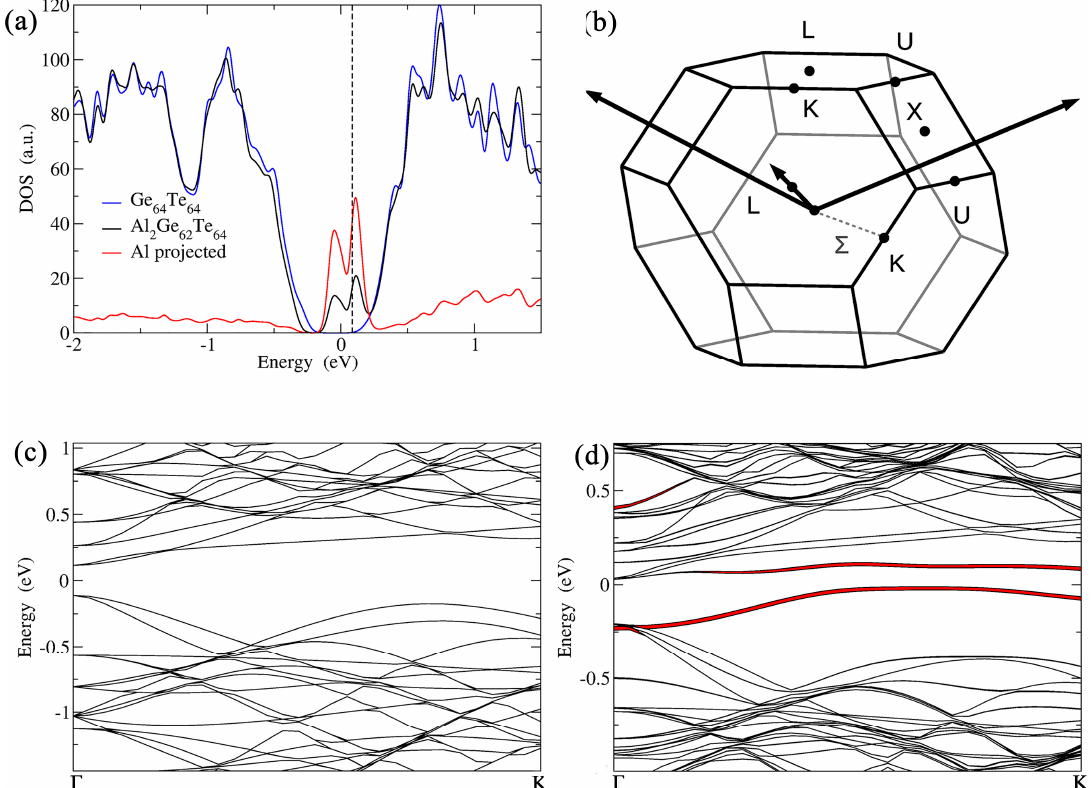
Figure 4. ( a ) Calculated DOS for Al 2 Ge 62 Te 64 (Ge 0.97 Al 0.03 Te) model, which is compared with that of the pristine cubic phase Ge 64 Te 64 (c-GeTe). The Fermi level ( E F ) of pristine c-GeTe is set arbitrarily at 0 eV. The dashed line represents the shifted E F for the doped compositions. Additional Gaussian smearing of 25 meV was applied and the Al projected DOS is magnified for a better readability of the curves. ( b ) Brillouin zone of c-GeTe. Band structures for ( c ) c-Ge 64 Te 64 using a 4 × 4 × 4 supercell showing band folding in the Γ → K ( ∑ ) direction, and ( d ) Al 2 Ge 62 Te 64 (Ge 0.97 Al 0.03 Te) highlighting Al projections. Line thickness is proportional to the projection of the wave function on the Al (in red)